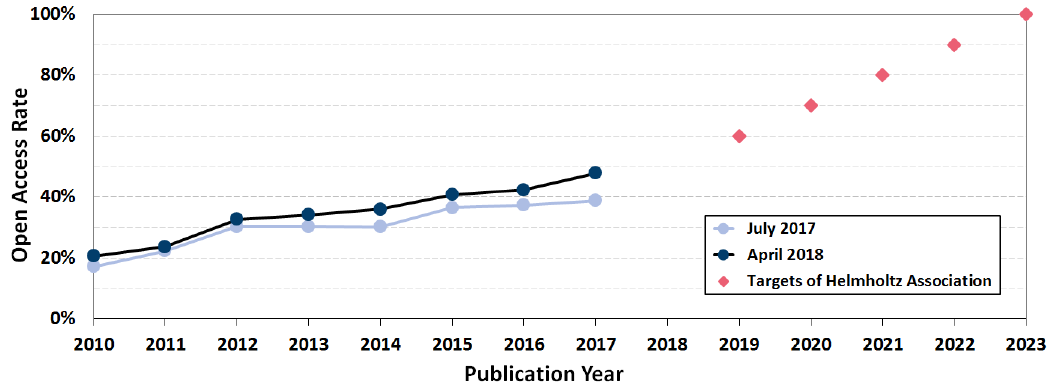
Figure 4. The open access rate of Forschungszentrum Jülich before the Open Access Week on Tour (July 2017, light blue) and in April 2018 (dark blue). The targets set by the Helmholtz Association are highlighted in red.